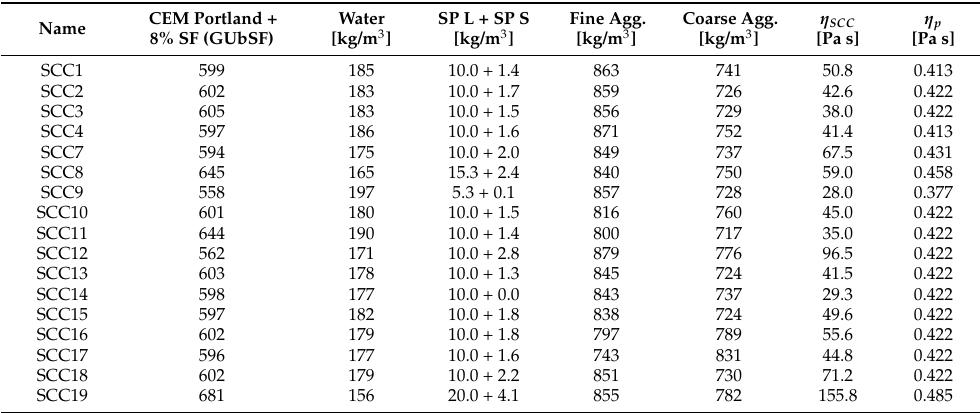
Table A3. Dosages and dynamic viscosities of the self-compacting concretes in Feys et al. [39].